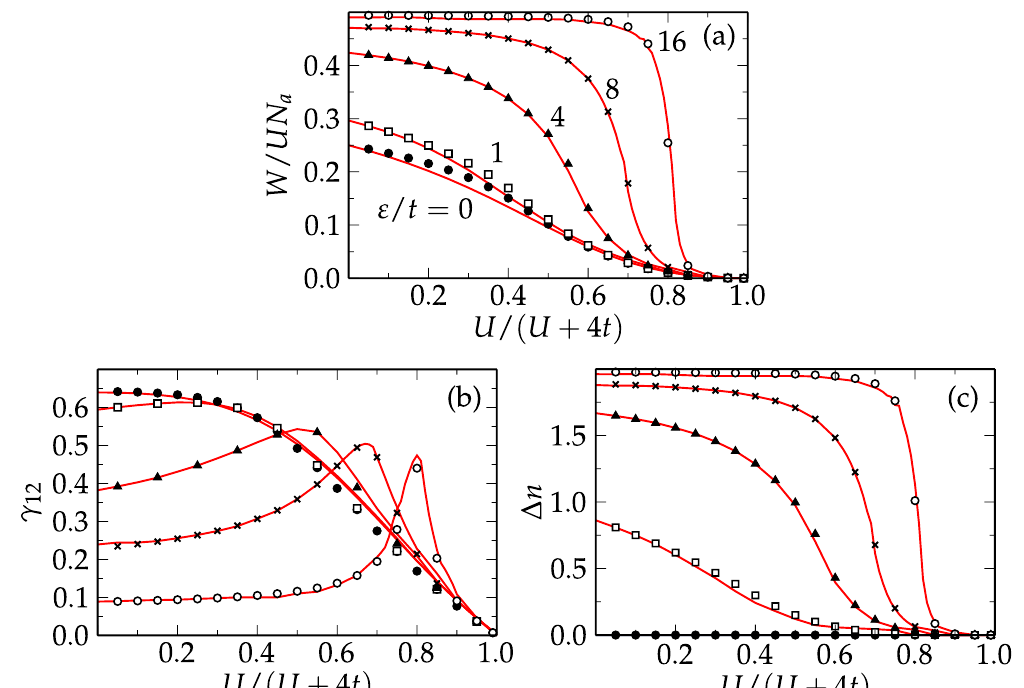
Figure 4. Ground-state properties of bipartite Hubbard rings having N a = 14 sites at half-band filling ( N = 14) as function of the Coulomb repulsion strength U / t : ( a ) average number of double occupations per site W / ( UN a ) ; ( b ) NN bond order γ 12 ; and ( c ) charge transfer ∆ n = γ 22 values of the energy-level splitting ε between the sublattices are considered, which are indicated by numbers in ( a ). The solid curves are the results obtained with LDFT in conjunction with the scaling approximation W sc , while the symbols correspond to exact Lanczos diagonalizations. Reproduced with permission from Reference [70]. c (cid:13) American Physical